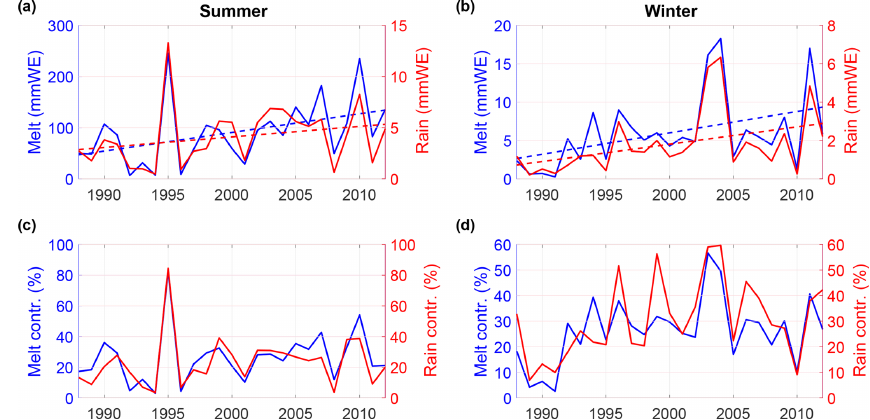
Figure 11. (a, b) Net melt and rainfall associated with summer and winter events, where the melting and rainfall have been summed over days − 1 to 3 (days − 1 to 6 for melting during summer events, Fig. 10). (c, d) Contributions of the melting and rainfall during melt events to the total melt and rainfall in the current